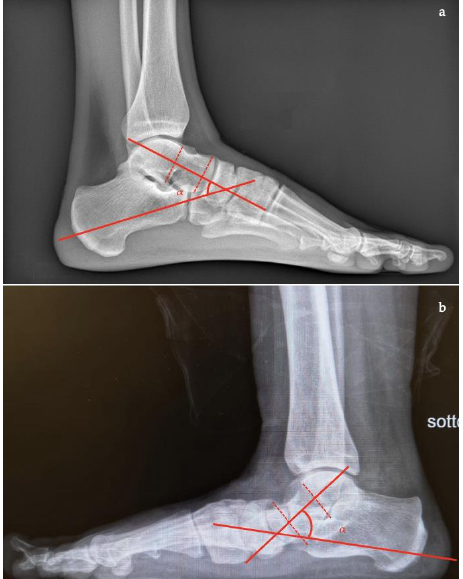
Figure 7. Talocalcaneal angle (formed by the long axis of the rearfoot and the midtalar line) in lateral X-ray view. ( a ) Normal foot, 45°; ( b ) pathological flatfoot, 52°. In Saltzman view (Figure